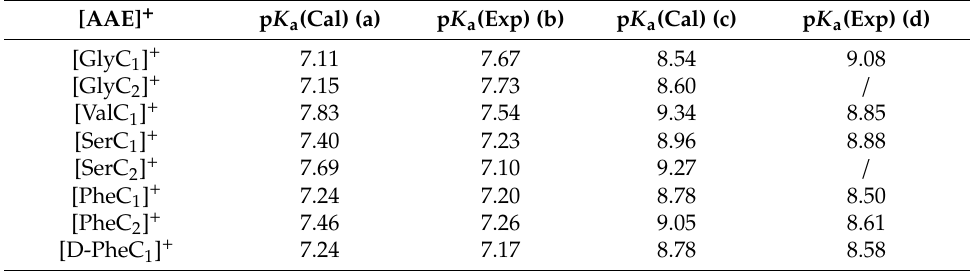
Table 6. The theoretical and experimental p K a values of [AAE] + in water and ethanol.